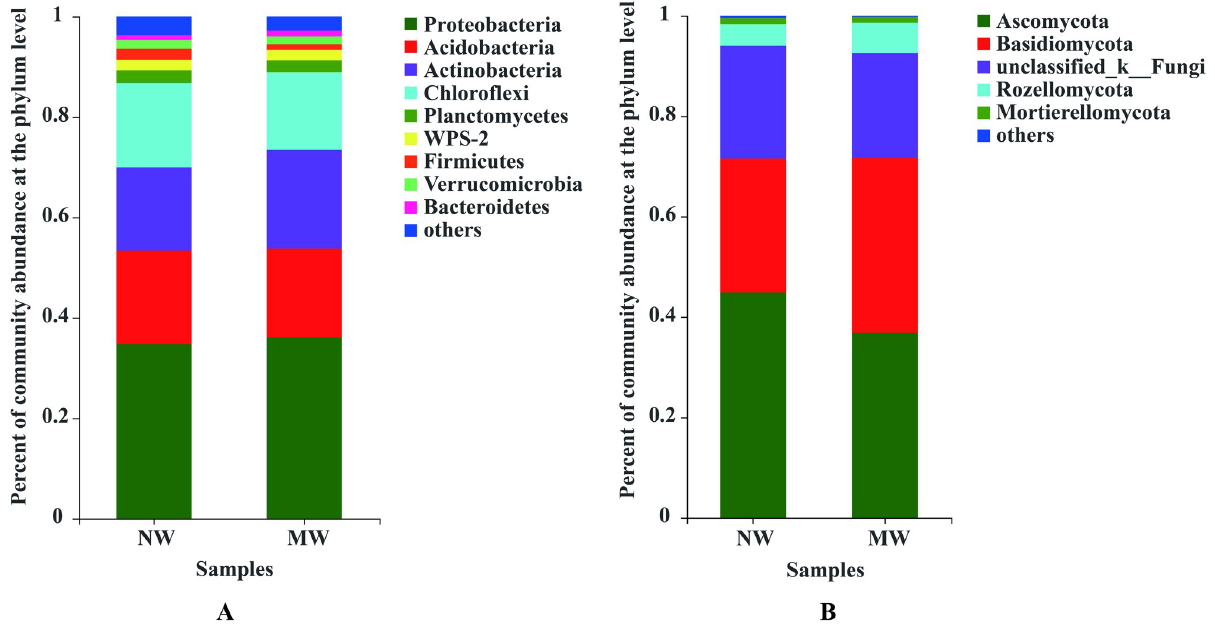
Fig 2. Compositions of soil bacterial (A) and fungal (B) communities at the phylum level between the NW and MW treatments. Note . Only the phyla with relative abundances greater than 1% are presented in Fig 2. NW: no weeding in the star anise plantation, and MW: mechanical weeding in the star anise